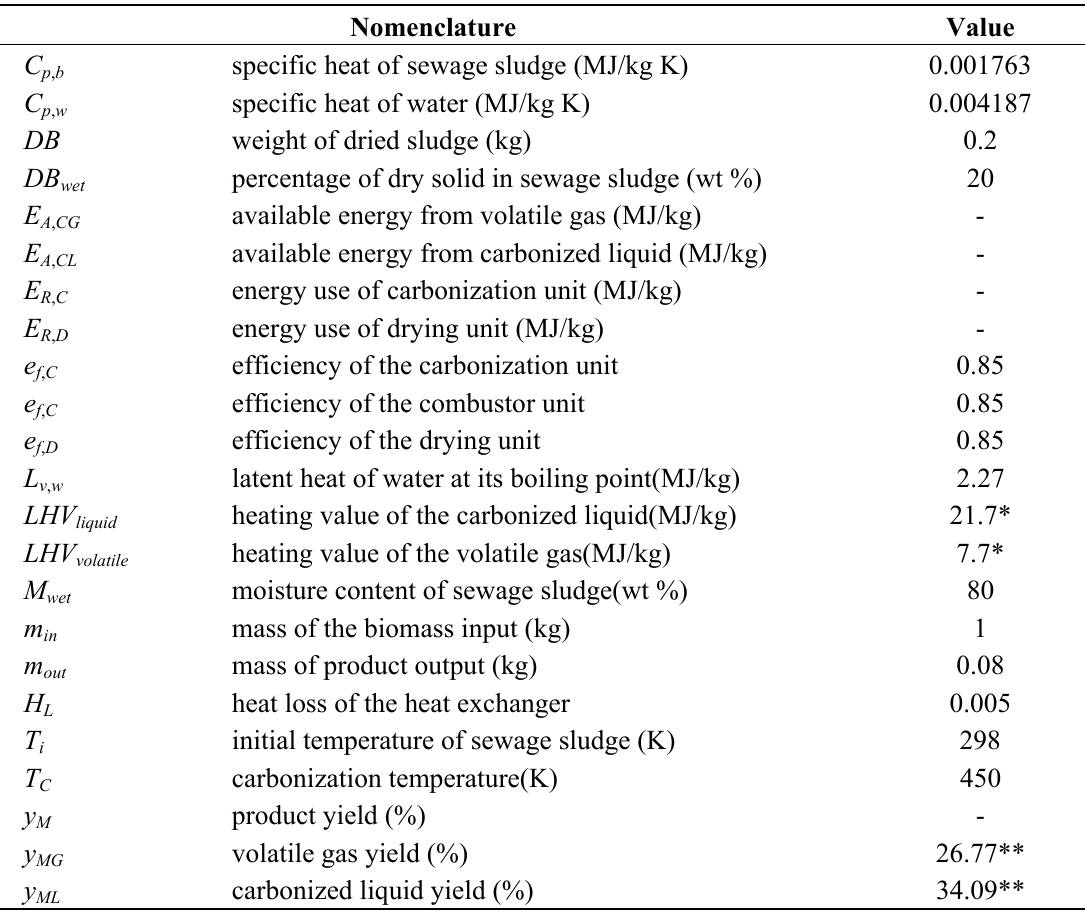
Table A1. Nomenclature and parameter values.